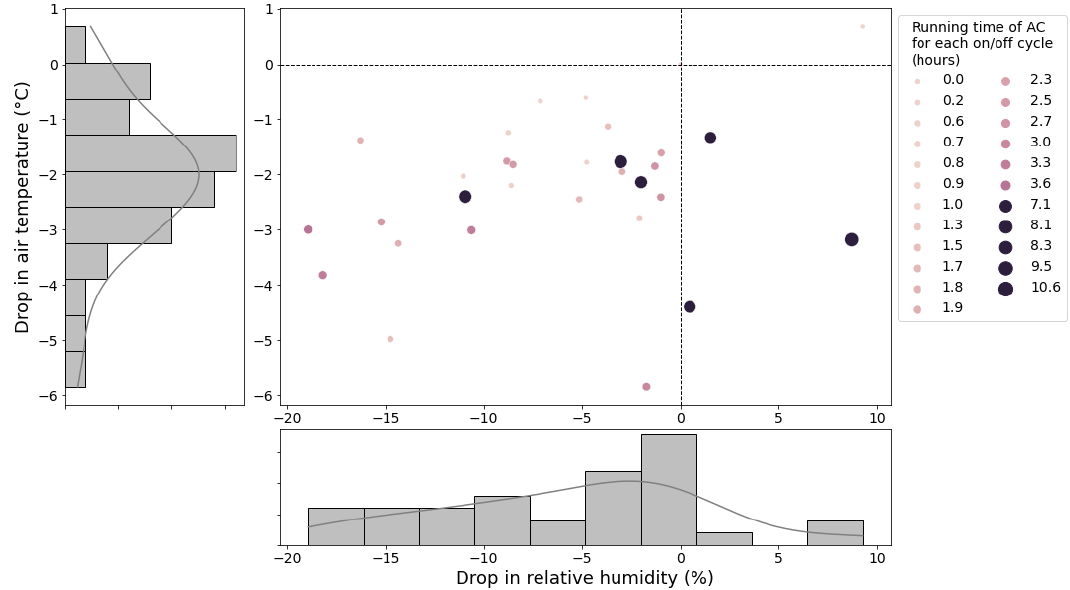
Figure 4. The drop in temperature and relative humidity for each cycle when the air conditioner is turned on and off.